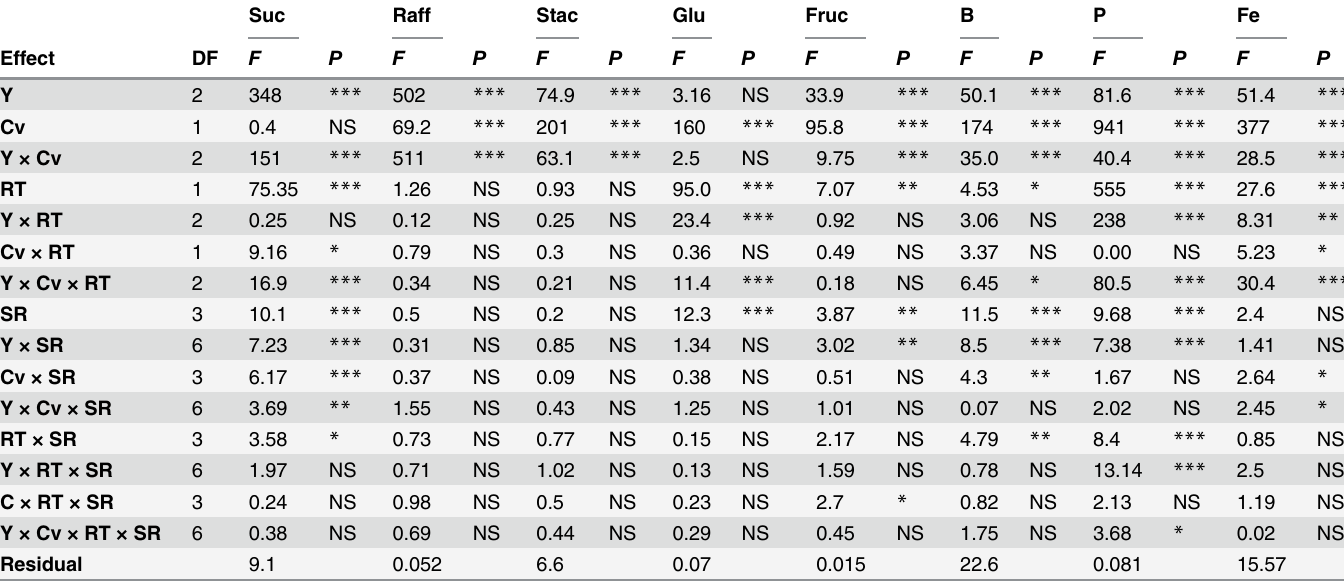
Table 4. Analysis of variance ( F and P values) of the effects of year (Y), cultivar (Cv), row-type (RT, either single- or twin-rows), and seeding rate (SR) on the concentrations of seed sugars (sucrose, raffinose, stachyose, glucose, and fructose, mg g -1 ) and boron (B, mg kg -1 ), phosphorus (P, g kg -1 ), and iron (Fe, mg kg -1 ) in soybean cultivars 94M80 and GP-533 in Beulah fine sandy loam soil.